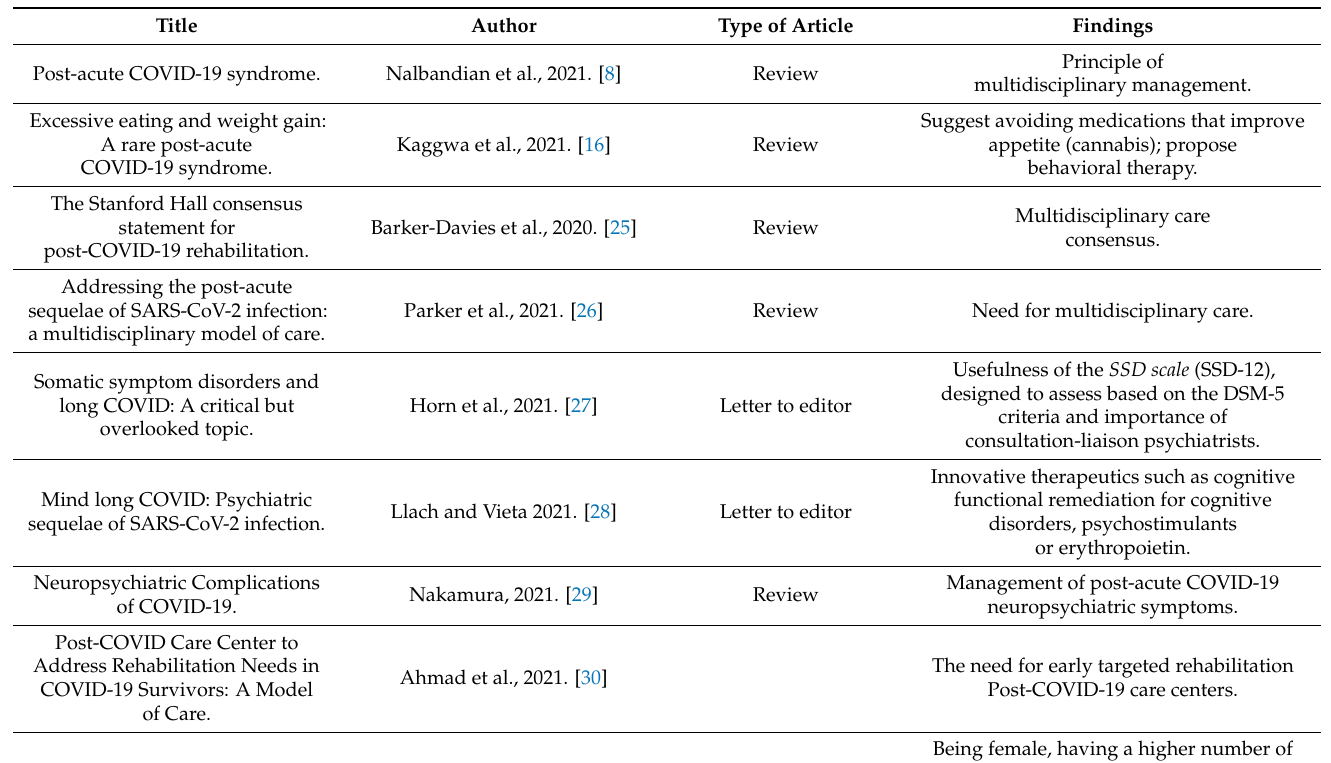
Table 1. Synopsis of articles